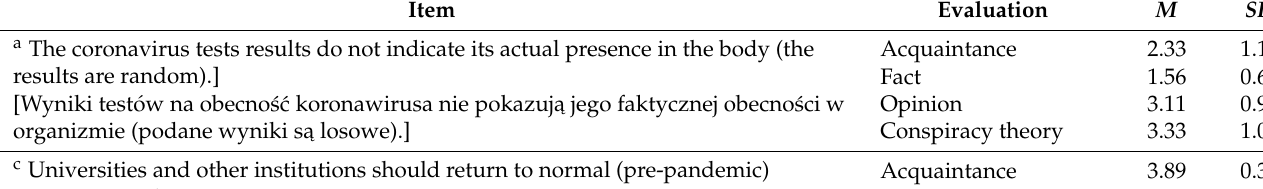
Table A1. Cont. Item Evaluation